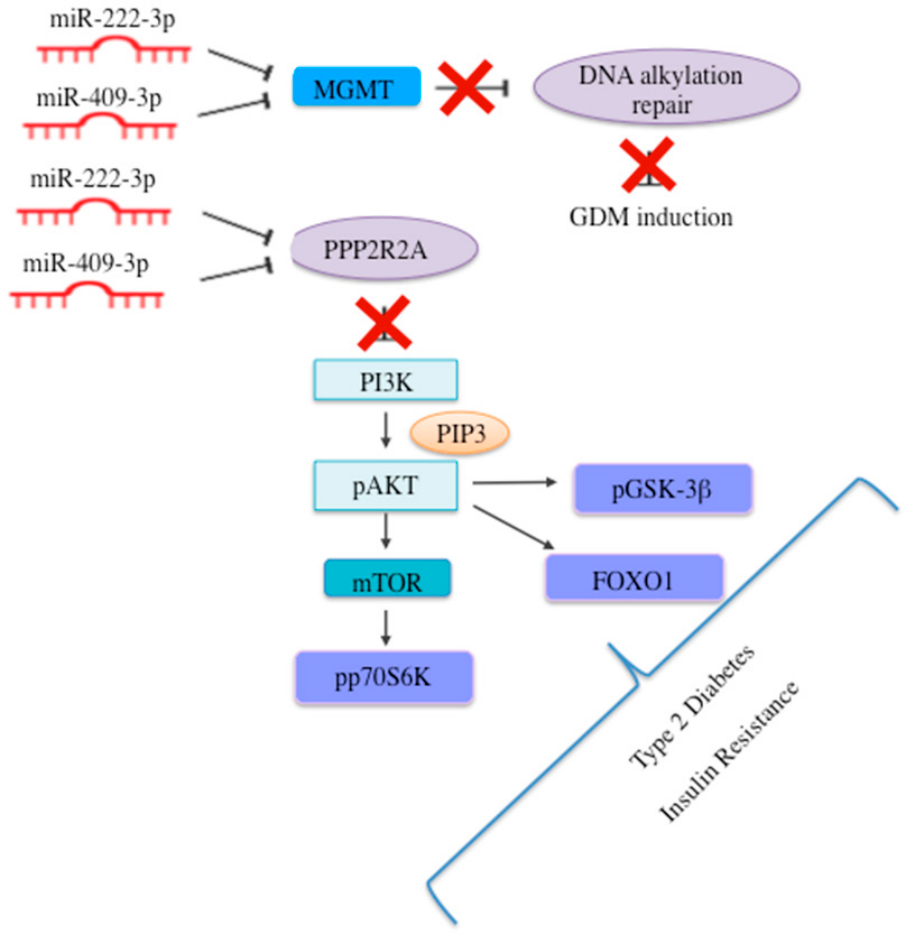
Figure 6. Hypothesis of the role of miR-222-3p and miR-409-3p and their validated targets in the pathophysiology of GDM.